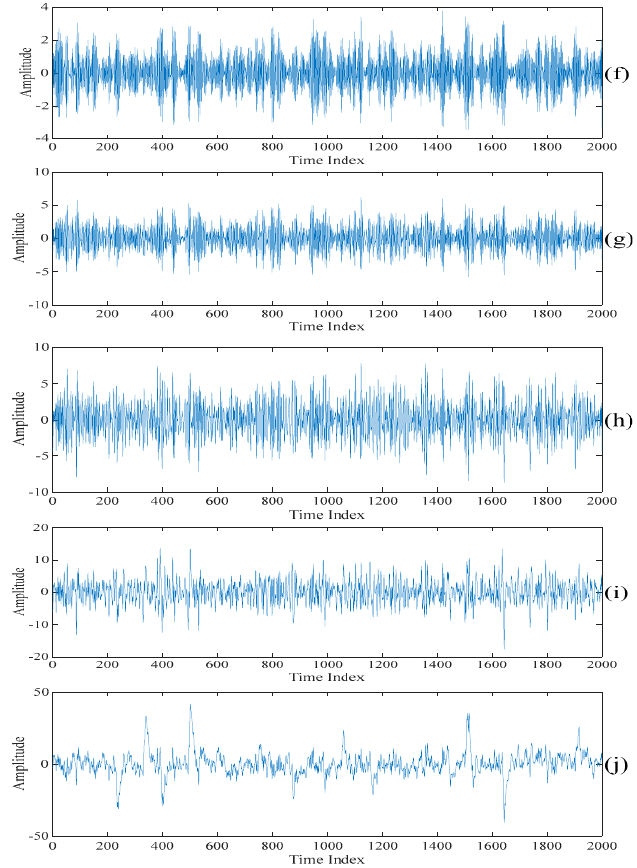
Figure 6. The sums of the singular spectrum analysis components starting from the last singular spectrum analysis component. ( a ) The last singular spectrum analysis component. ( b ) The sum of the last two singular spectrum analysis components. ( c ) The sum of the last three singular spectrum analysis components. ( d ) The sum of the last four singular spectrum analysis components. ( e ) The sum of the last five singular spectrum analysis components. ( f ) The sum of the last six singular spectrum analysis components. ( g ) The sum of the last seven singular spectrum analysis components. ( h ) The sum of the last eight singular spectrum analysis components. ( i ) The sum of the last nine singular spectrum analysis components. ( j ) The sum of all the singular spectrum analysis components.